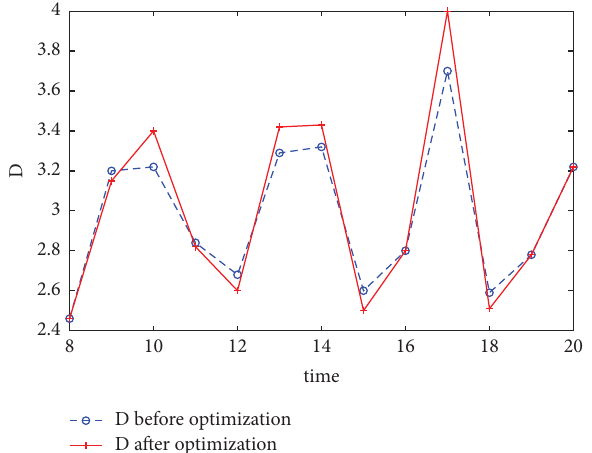
Figure 19: Comparison chart of D before and after optimization.